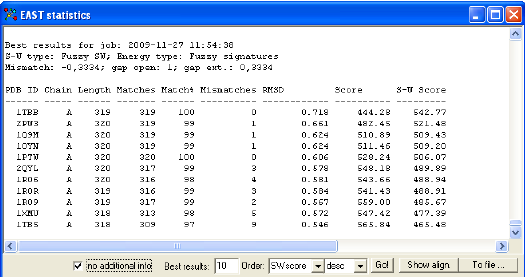
Fig. 12. Results of the similarity searching using the EAST.